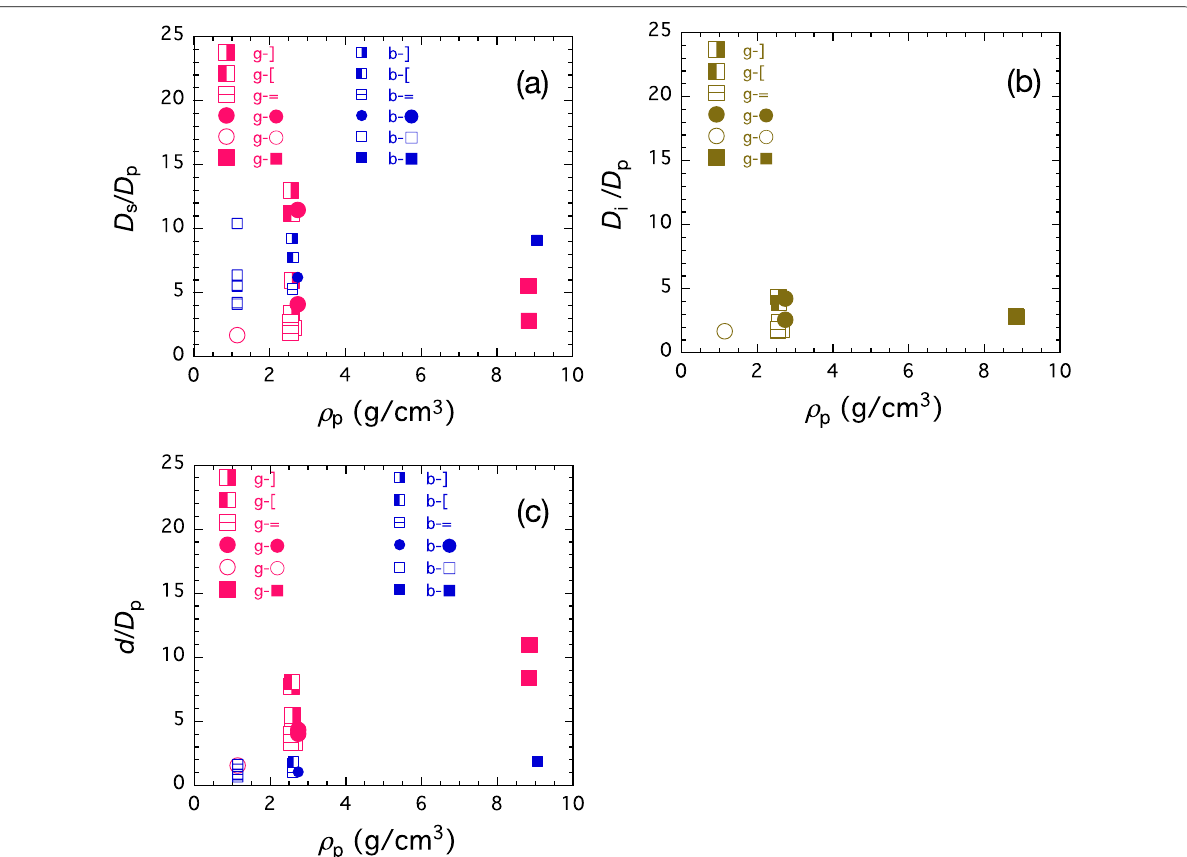
Fig. 3 Crater diameters (surface and inner) and depth normalized by projectile diameter, D p , as a function of projectile bulk density, ρ p , in g/cm 3 , a D s / D p , b D pi / D p , and c d / D p . Symbols, “g-” and “b-”, indicate porous gypsum and basalt targets, respectively. Projectile structures and orientations are also indicated; symbols “]”, “[”, “ ”, “filled black circle”, and “filled black square” indicate the impact of closed tubes from the closed side, the impact = of closed tubes from the open side, the impact of open tubes from one open side, the impact of solid spheres, and the impact of solid cylinders, respectively. Symbols “open circle” and “open square” indicate the previous results of the impact of a spherical nylon projectile onto a porous gypsum block (1 point; Yasui et al. 2012) and of cylindrical nylon projectiles onto basalt blocks (6 points; Dohi et al.